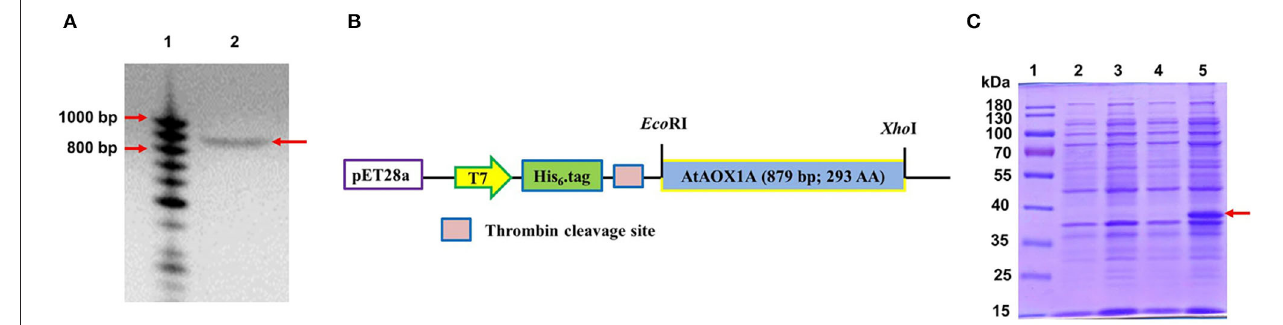
FIGURE 1 | Cloning and expression of AtAOX1A in E. coli . (A) Polymerase chain reaction (PCR) amplification of 879 bp AtAOX1A using gene-specific primers. Lane 1, 50–1000 bp DNA ladder; lane 2, PCR amplified AtAOX1A (indicated with arrow). (B) Schematic diagram of the expression vector construction. The gene sequences were cloned into restriction endonuclease Eco RI and Xho I recognition sites of the pET28a vector to produce N-terminal His 6 -tag recombinant AtAOX1A protein. (C) Total protein of both E. coli /pET28a and E. coli /pAtAOX1A cells were separated on 12.5% (w/v) sodium dodecyl sulfate-polyacrylamide gel electrophoresis (SDS-PAGE) for recombinant protein expression analysis. Each well was loaded with 40 µ g of protein. Lane 1, 10–180 kDa protein marker; lane 2, E. coli /pET28a; lane 3, E. coli /pET28a induced with 0.1mM IPTG; lane 4, E. coli /pAtAOX1A; lane 5, E. coli /pAtAOX1A induced with 0.1mM IPTG. The induced rAtAOX1A is indicated with an